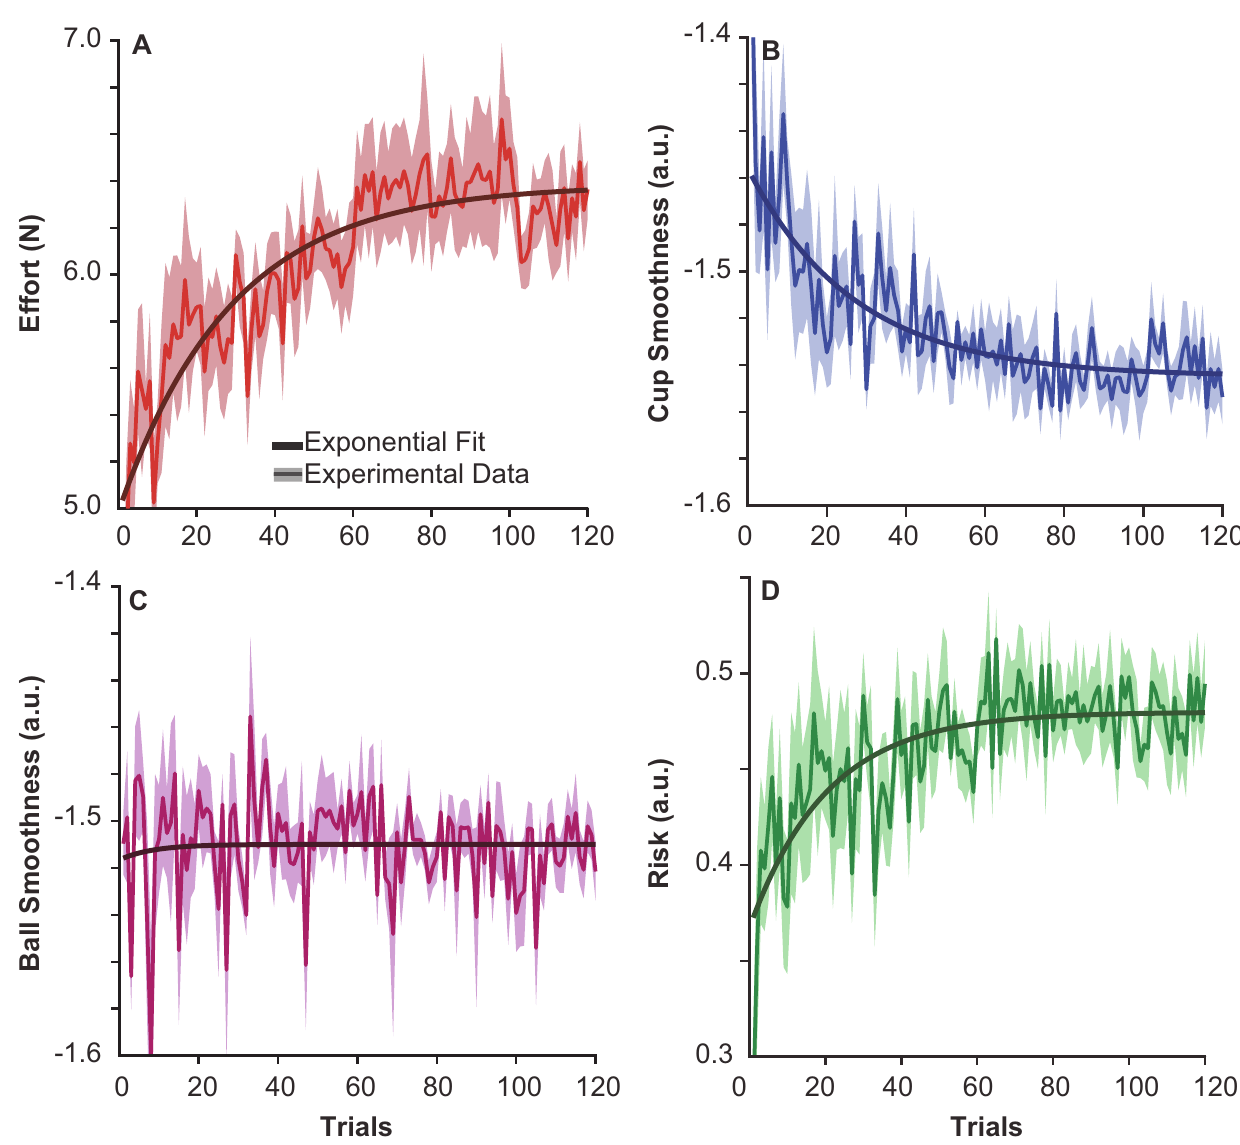
Fig 7. Subject performance measured by effort, smoothness and risk metrics: A. Root mean square (RMS) of F and trials. The solid red line shows the mean across subjects; the shading shows the standard error of the mean. The trend in the data was fit with: A = 1.396, τ = 28.76, B = 4.987, and R 2 = 0.80. B. Smoothness of the cup trajectory quantified by the SPARC method averaged across subjects over 120 trials. The trend in the data was fit with: A = 0.108, τ = 19.44, B = -1.650, and R 2 = 0.71. Note that larger negative numbers indicate less smooth kinematics C. Smoothness of the ball kinematics calculated using the SPARC method averaged across subjects over the experiment is shown in magenta. The trend in the data was fit with: A = -0.007, τ = 8.44, B = -1.5, and R 2 = 0.003. D. Risk quantified as (1-energy margin); decreasing energy margin is expressed as increasing risk. The average risk across subjects over trials is shown by the solid line. The data was fit with the same exponential function: A = 0.086, τ = 23.32, B = 0.295, and R 2 =